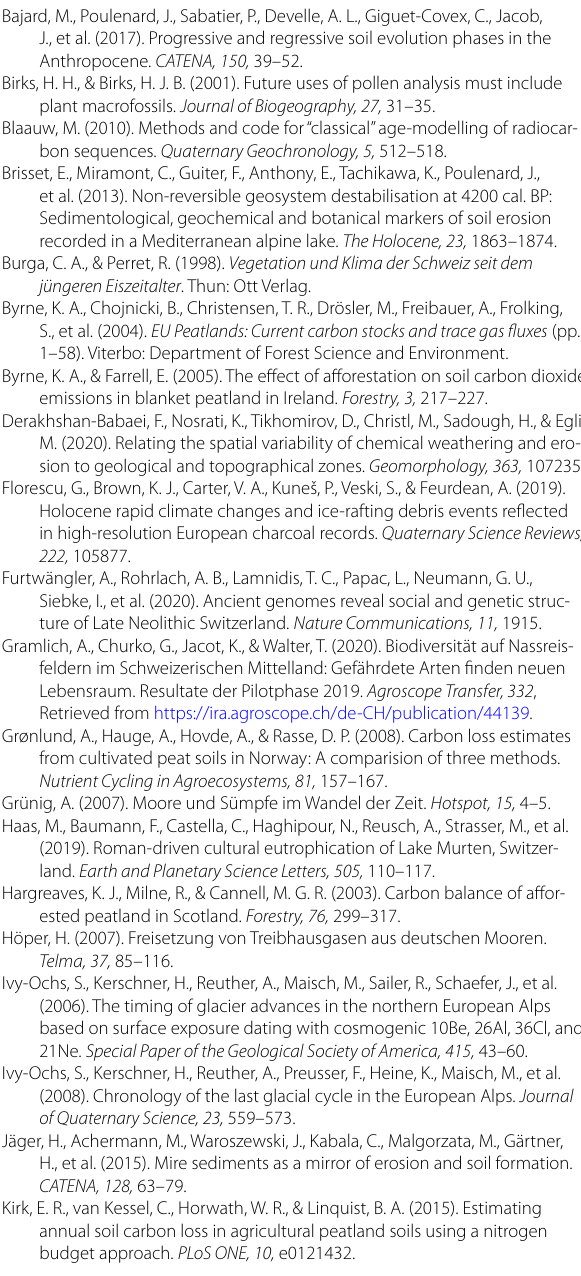
Additional file 1: Table S1. Physical characteristics, LOI (loss on ignition) and organic C of the investigated samples. Additional file 2: Table S2. Total chemical composition of the investi- gated